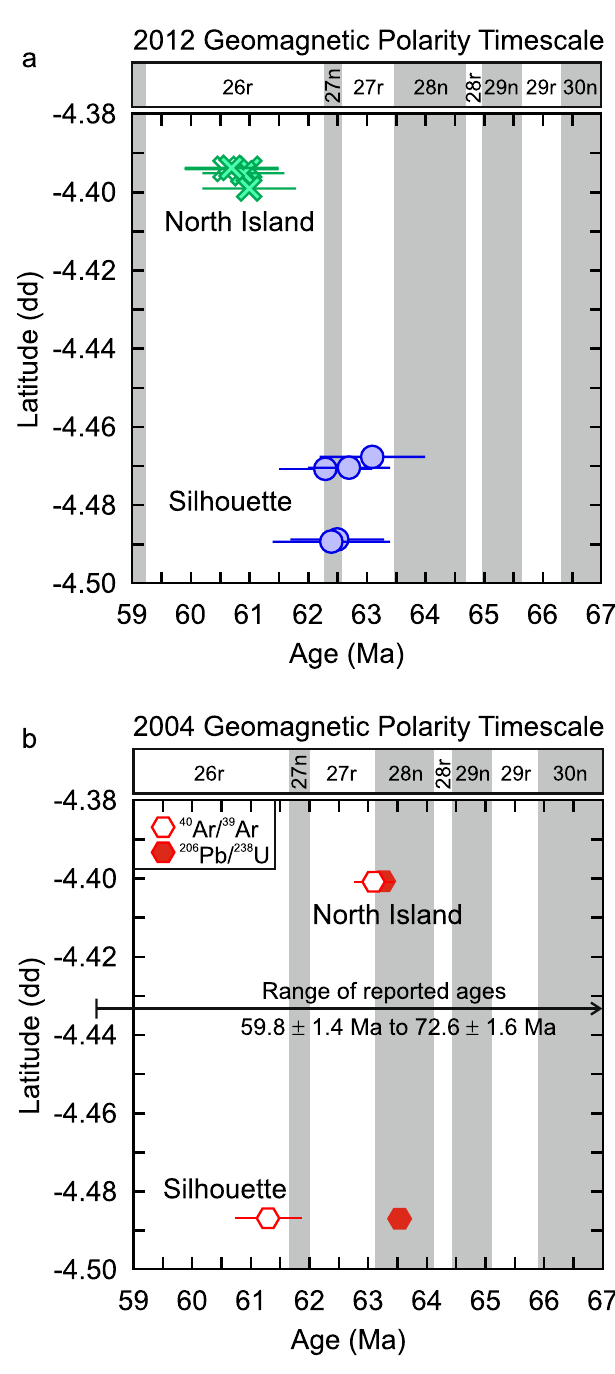
Figure 2. Secular latitudinal variation of the rocks from the Silhouette/North Island complex. ( a ) The zircon U/ Pb ages (with uncertainty) are plotted based on their latitude in decimal degrees (dd) and the 2012 geomagnetic polarity timescale 24 . ( b ) The weighted zircon U/Pb ages (with uncertainty) 14 , weighted mineral 40 Ar/Ar 39 ages (with uncertainty) 14 and complete range of previously reported ages of Silhouette and North Island are plotted relative to the 2004 geomagnetic polarity timescale 1, 2, 14, 43